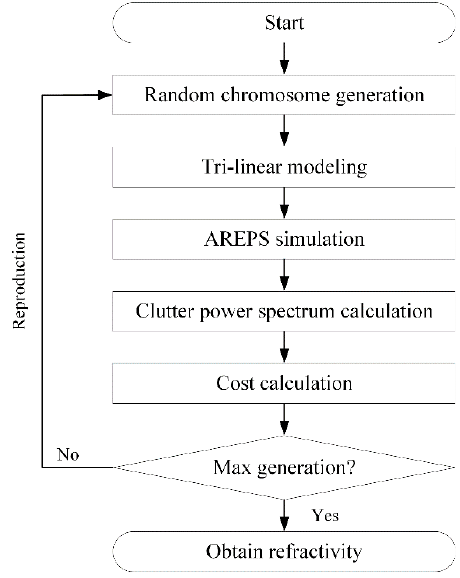
Figure 7. GA process for estimating atmospheric refractivity. Table 1. Detailed information of the GA.